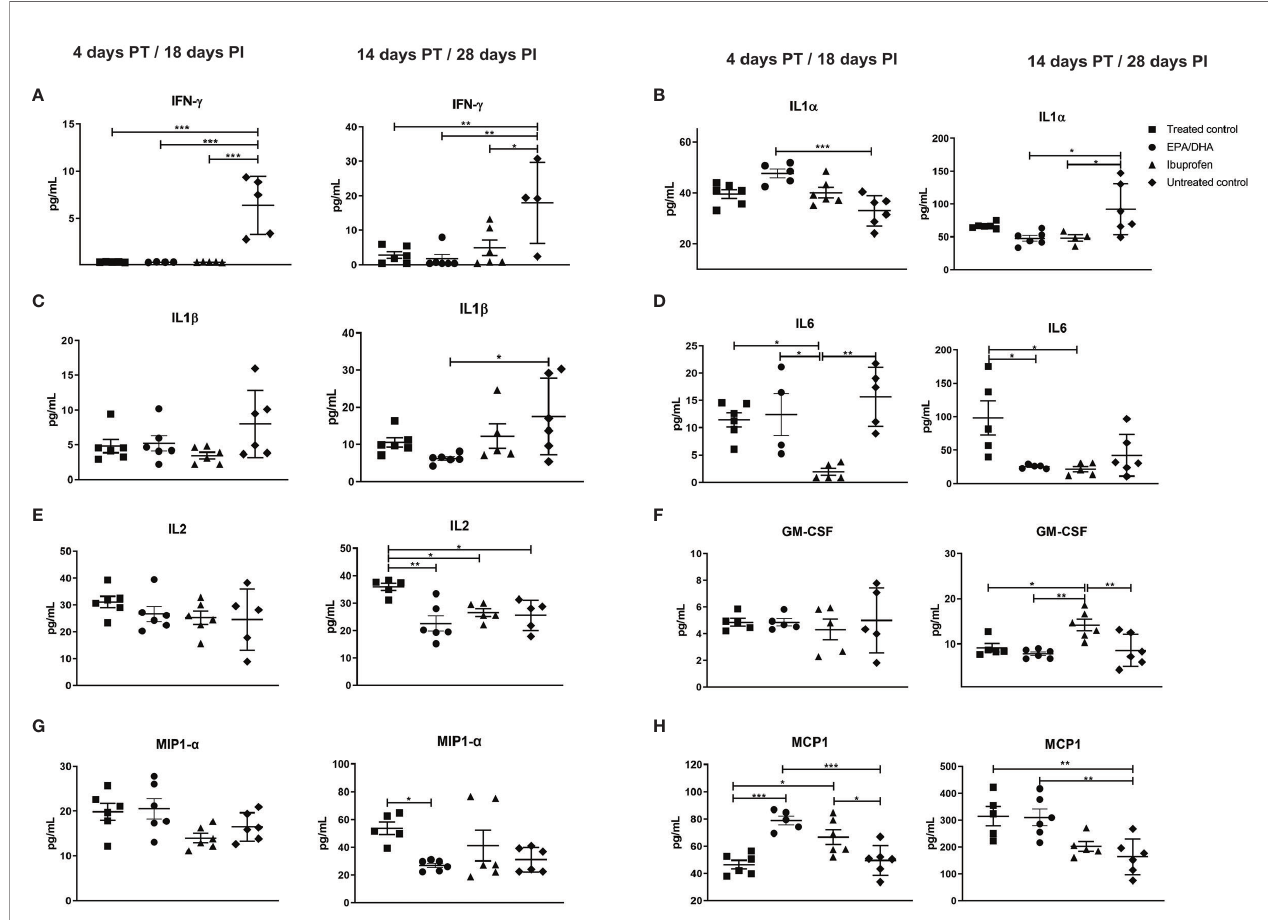
FIGURE 3 | Treatment effects on lung cytokine/chemokines levels. (A) IFN- g , (B) IL-1 a , (C) IL-1 b , (D) IL6, (E) IL2, (F) GM-CSF, (G) MIP-1 a and (H) MCP-1. All data are presented in pg/mL. All mice except untreated controls were on standard TB antibiotics Rifafour ® for 4 days of treatment, then rifampicin and isoniazid (RH) for 10 days. All values represent mean ± SEM. Results repeated in two experiments, data shown for one experiment (n = 6 per group). One-way ANOVA followed by Tukey ’ s post-hoc test was used to compare means, *P < 0.05, **P < 0.01, ***P < 0.001. EPA, eicosapentaenoic acid; DHA, docosahexaenoic acid; IL, interleukin; IFN- g , interferon g ; IL-1 a , interleukin 1 alpha; IL-1 b , Interleukin 1 beta, GM-CSF, granulocyte-macrophage colony-stimulating factor; MIP-1 a , macrophage in fl ammatory protein 1-alpha and MCP-1, Monocyte chemoattractant protein-1; PT, post-treatment; PI,